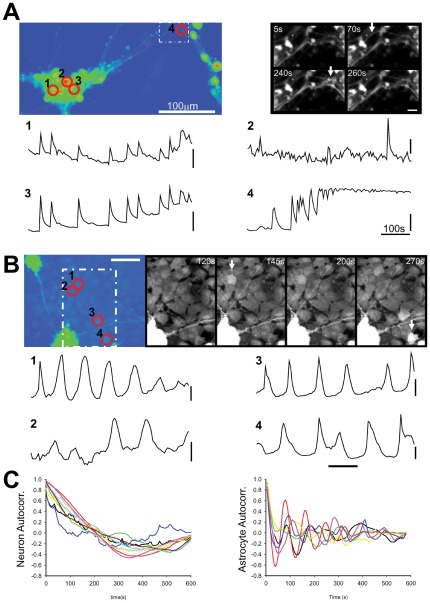
Stem cell derived neurons and astrocytes display spontaneous activity.
A. Image on the left displays an NT2N neuronal aggregate with extending processes. The white dotted area is displayed expanded to the right at indicated time points during the experiment. White arrows indicate processes that become active during acquisition. Red numbered circles indicate exemplar active cells with corresponding fluorescence timecourse displayed below. Neurons can display synchronised activity (1,3). Propagating activity from distant processes can also be detected (4). B. Image on the left displays an NT2N-A coculture. Spontaneously active astrocytes are circled and numbered. White dotted area is displayed expanded to the right at indicated time points during the experiment. White arrows indicate active astrocytes. Fluorescence time courses from the astrocytes are illustrated below, indicating regular calcium oscillations. C. Autocorrelation analysis of neurons from experiment A and astrocytes from experiment B. Scale bars A-1-4: 2, 0.5, 10, 10%. B-1-4: 5, 5,10, 10%. Cells were used within 14 days of differentiation.